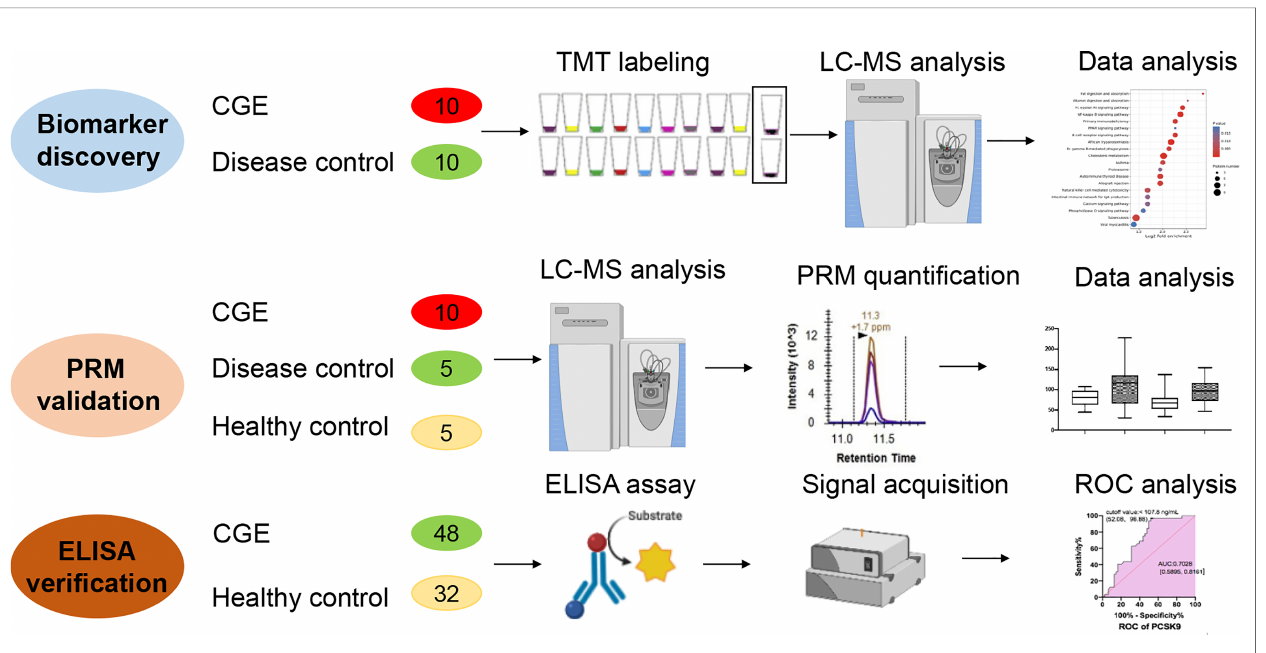
FIGURE 1 | The work fl ow of this